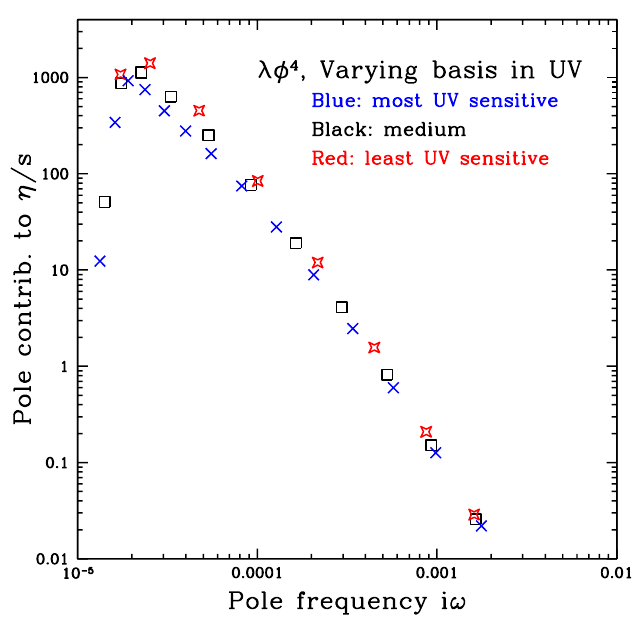
JHEP05(2018)084 Figure 4 . Pole locations for (cid:12)xed N = 12 and M = 12 ; 14 ; 16, with p 0 = 0 : 5 ; 1 ; 2. As basis functions are added at large p and the scale of sensitivity is shifted towards large p , pole locations move and the lowest observed frequency gets lower. Figure 5 . Pole locations when we apply the variational Ansatz method to the collision operator C in the relaxation-time approximation, with a (cid:12)xed relaxation time or with (cid:28) / p (each scaled to give the same (cid:17) result as the full case). { 13